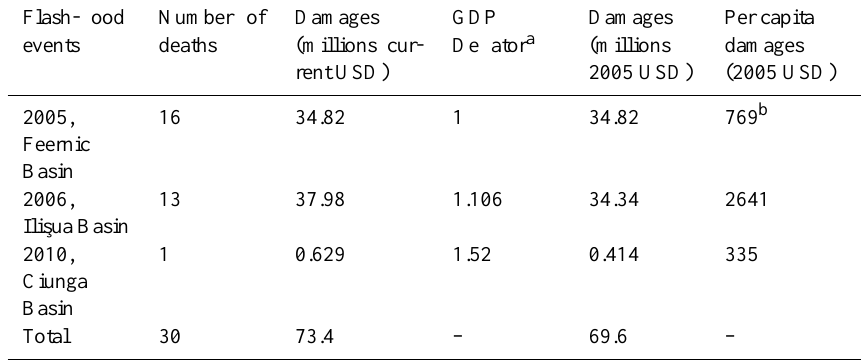
Table 4. The impact of analyzed flash-flood events on socio-economic life.